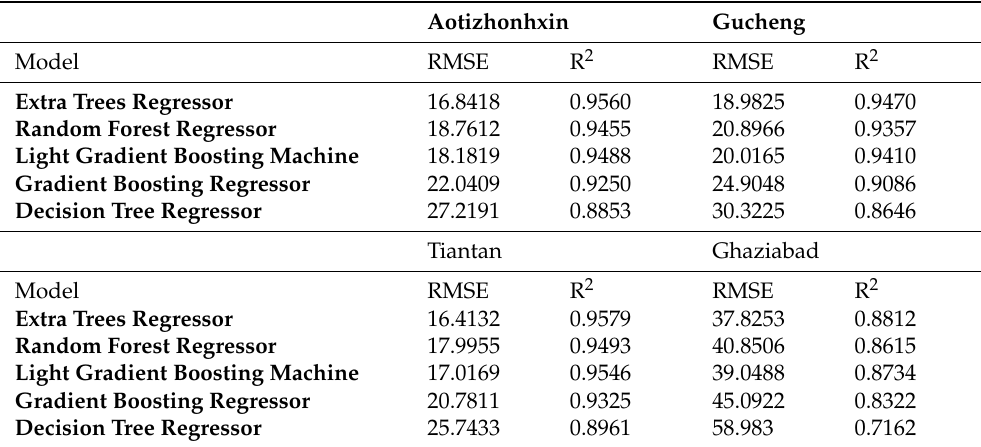
Table 3. Comparison table for regressor used for deciding estimator in iterative imputation.